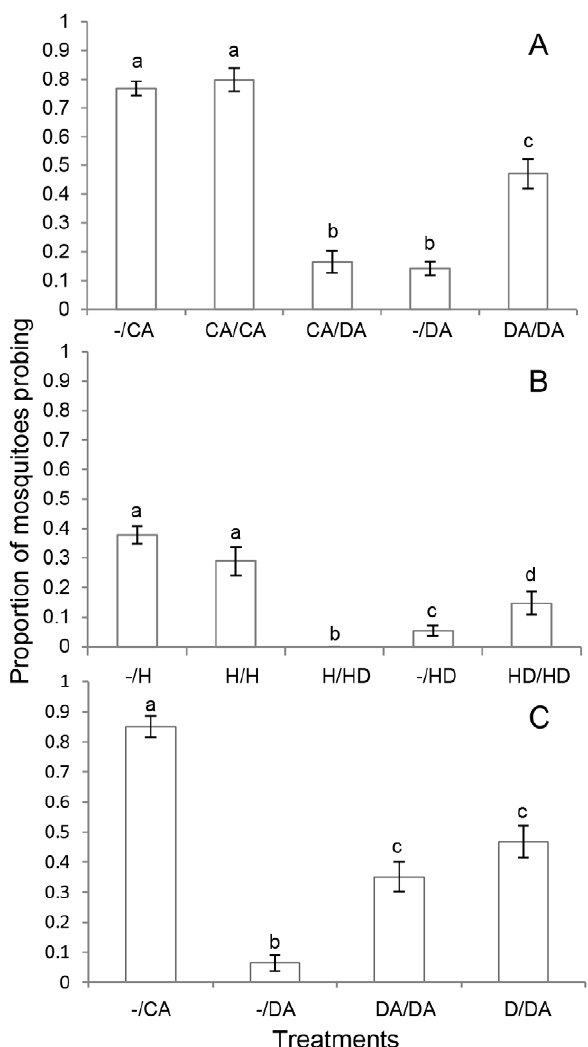
Figure 1. Behavioural repellency on second exposure. Propor- tion of female Aedes aegypti mosquitoes probing in response to a treatment on first exposure (treatment 1) or to a second treatment after pre-exposure to a treatment 3 hours previously (treatment 1/treatment 2). Treatments were A : a control arm (CA) (0.5 ml ethanol), a DEET treated arm (DA) (0.5 ml, 20% in ethanol); B : a hemotek heating device with nylon control (H) (0.5 ml hexane), a hemotek device with nylon spotted with DEET (HD) (0.5 ml, 20% in redistilled hexane); C : a section of nylon spotted with DEET with no other stimulus (D). Means are 6 SEM. Means with different letters are significantly different from each other (p , 0.05).